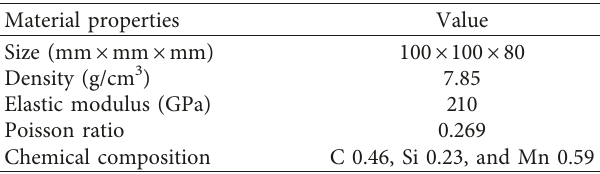
Figure 3: Scheme of milling tool wear experiment: (a) the whole tool wear condition monitoring system and (b) the relative position between the milling tool, the workpiece, and the three-axis accelerometer. Table 2: The main properties of the 45 steel.